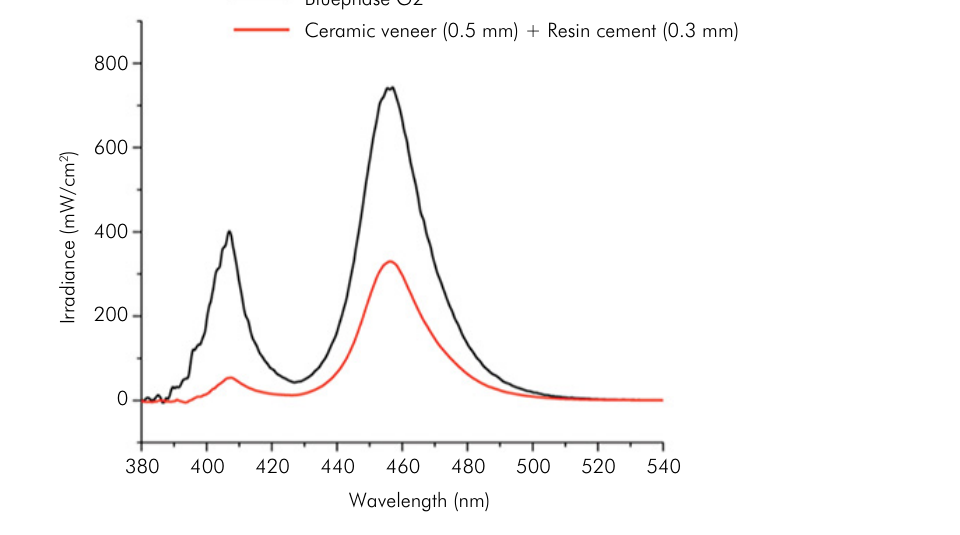
Figure 1. Spectral irradiance for multiwave LED, and irradiance attenuated by the interposition of the ceramic veneer and resin cement layers